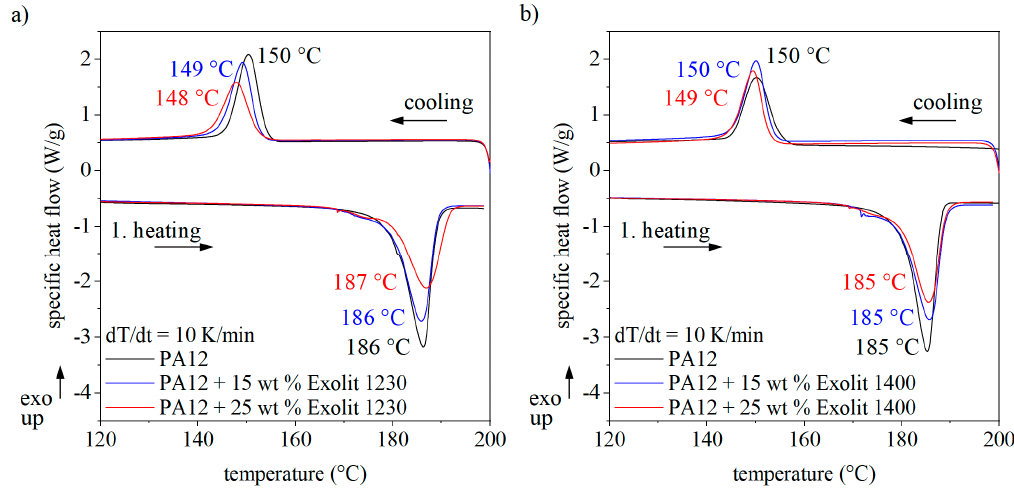
Figure 5. Thermogram of the polymer and composite powders for different flame retardant concentrations.